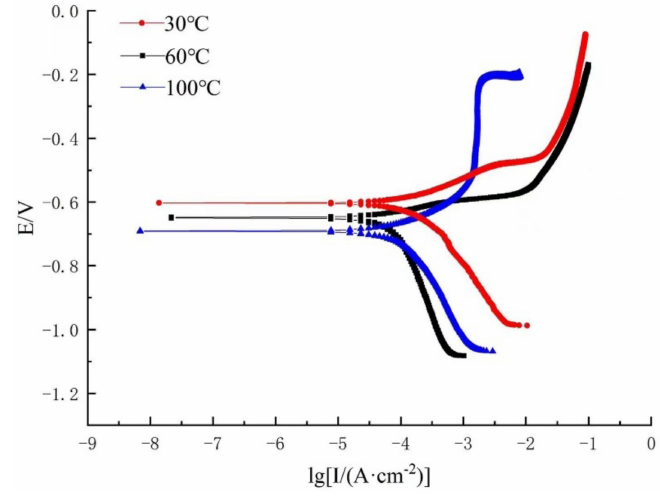
Figure 8. Polarization curve containing 3% Na 2 S.9H 2 O.